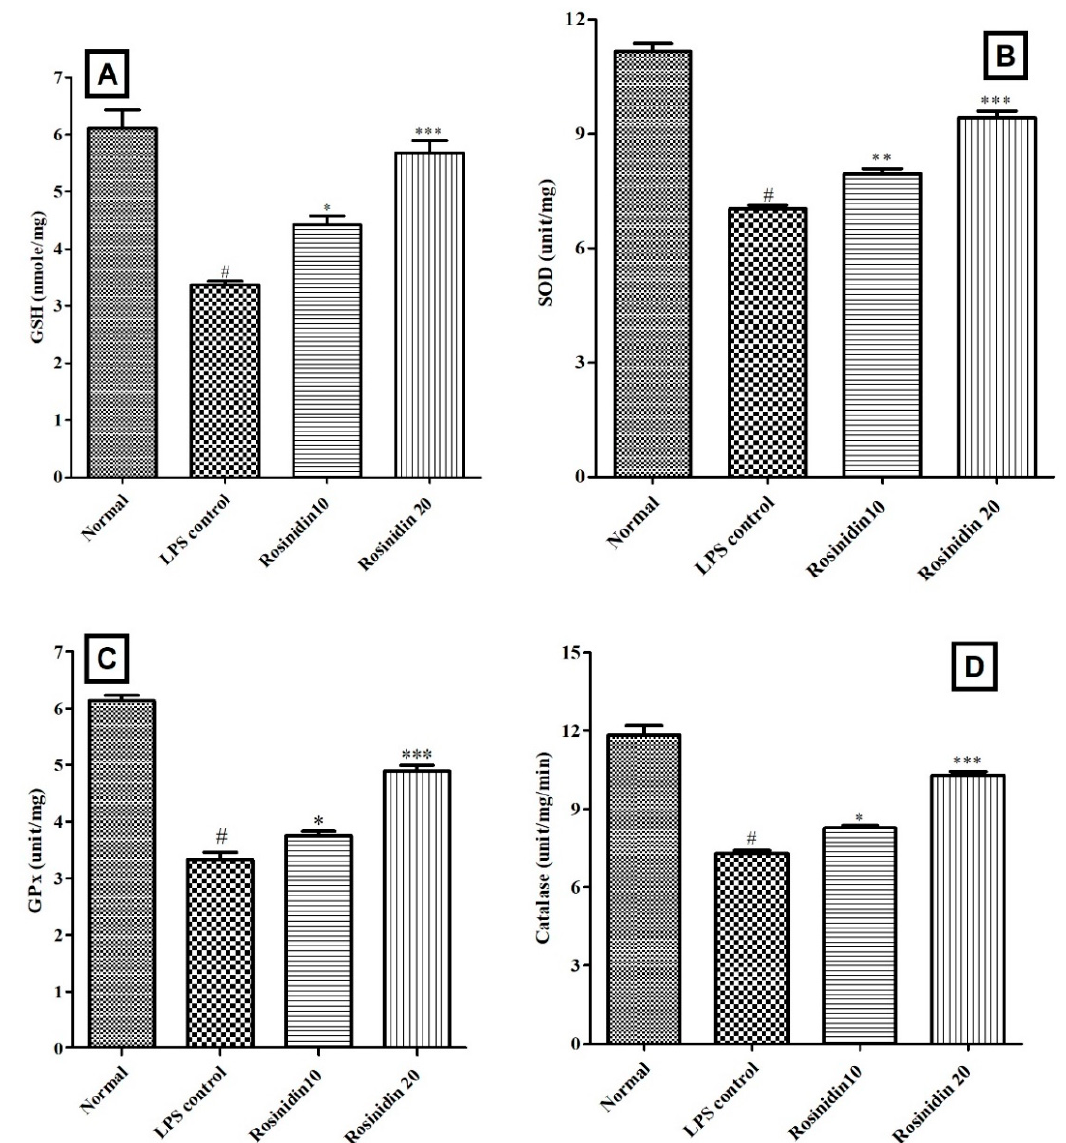
Figure 9. Effect of rosinidin on endogenous antioxidant status in LPS-treated rats. ( A ) Reduced glutathione, ( B ) superoxide dismutase, ( C ) glutathione peroxidase, and ( D ) catalase. Values are expressed in mean ± S.E.M. (n = 6). # p < 0.05 vs. normal control rats and * p < 0.05, ** p < 0.01 and *** p < 0.001 vs. LPS control rats. One-way ANOVA followed by Tukey’s post hoc test.